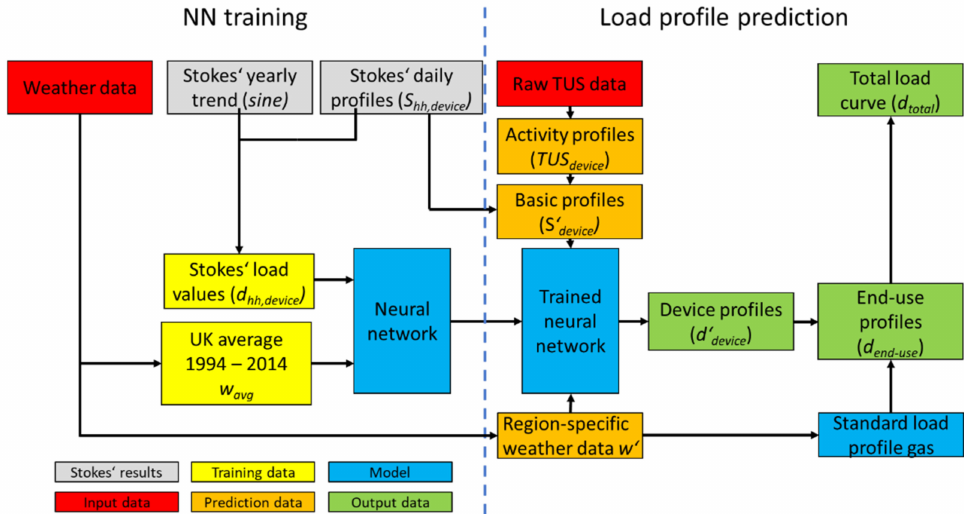
Figure 2. Structure of the model. The left side shows the training of the neural networks and the right side shows how we use the trained neural networks to predict the end-use load profiles. We scale each end-use profile by annual consumption to achieve the total load curve. NN, neural network; TUS, time-use